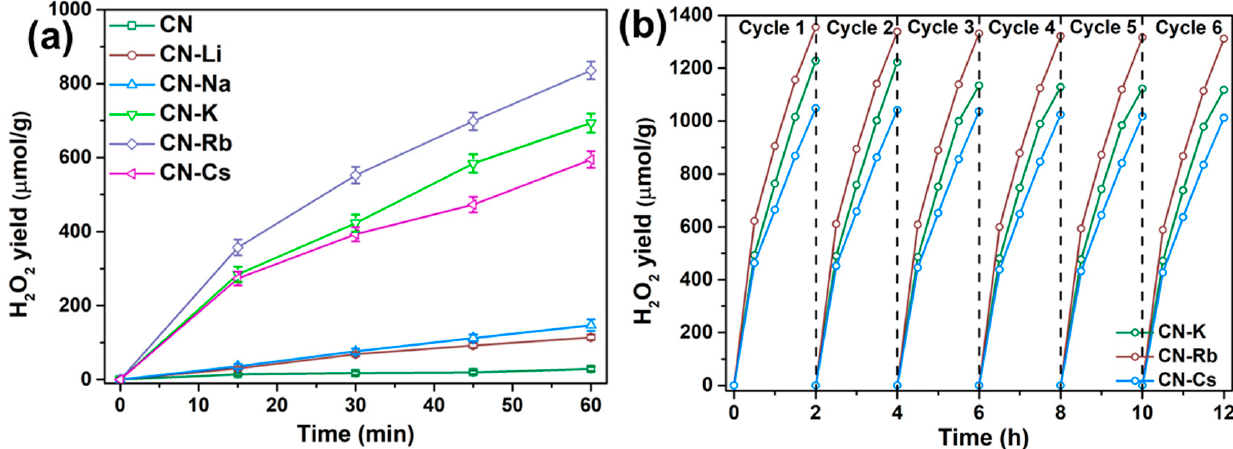
Figure 5. ( a ) Photocatalytic production of H 2 O 2 by the obtained specimens under white LED light. ( b ) Time course of the generation of H 2 O 2 employing CN-K, CN-Rb, and CN-Cs under white LED light.